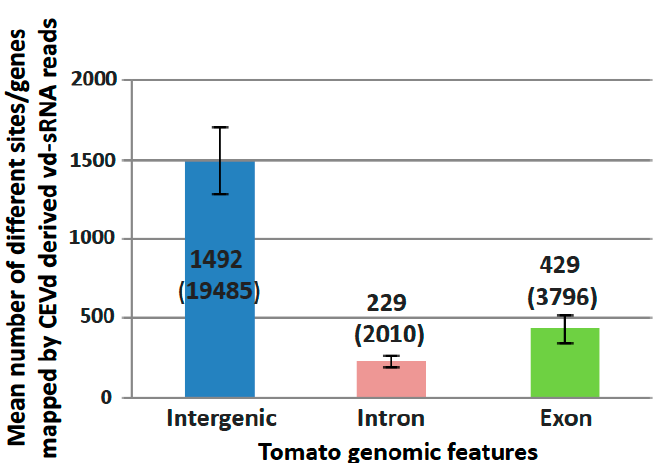
Figure 3. Mean number of different sites/genes mapped by CEVd derived sRNAs for each of the three tomato genomic features: intergenic region, exon (3 ′ and 5 ′ -UTR included), and intron. Standard deviations between samples are depicted as error bars. Mean number of reads for each feature are shown in parentheses.